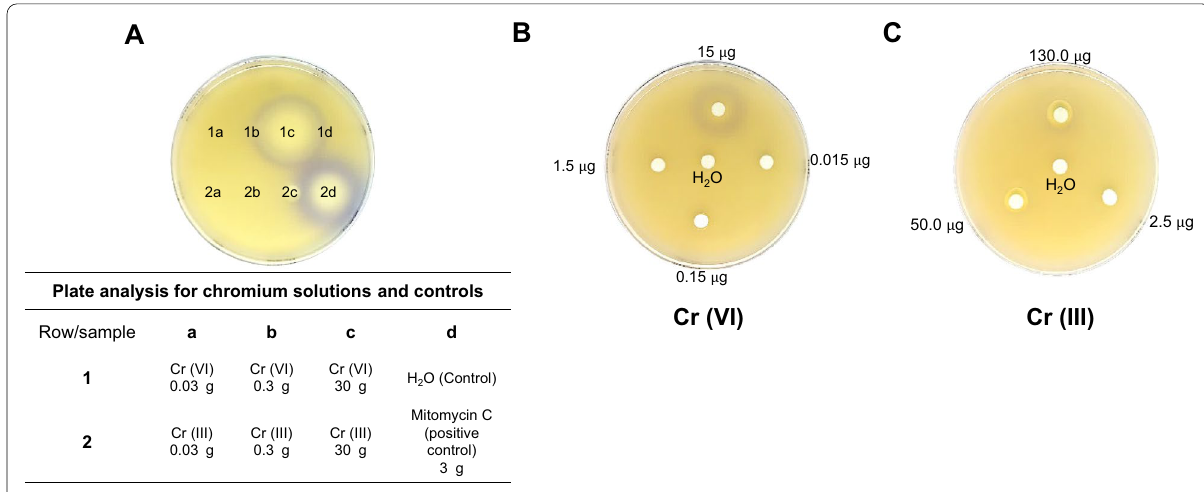
Fig. 4 Reporter strain activation by chromium toxicity. In A the reporter strain was exposed to different concentrations of chromium solutions at two oxidation states, the highly toxic Cr(VI), and the less toxic form Cr(III). The table indicates the concentrations applied on each section of the plate. The experiments were carried applying directly 3 µL of each chromium solution. B shows the effect of lower concentrations of Cr(VI) and C shows higher concentrations of Cr(III). The clear area on each experiment indicates cell death. The purple halos indicate reporter strain